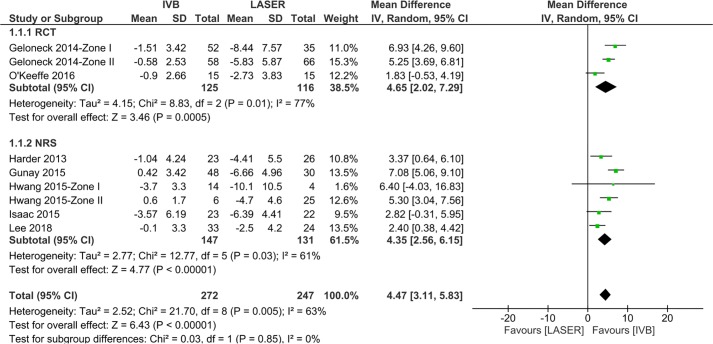
Forest plot of the comparison of SEQ between IVB and LASER treatments.Pooled estimates for mean differences and 95% CI in diopters between two treatments. The black diamond symbol shows the estimated true effect size.